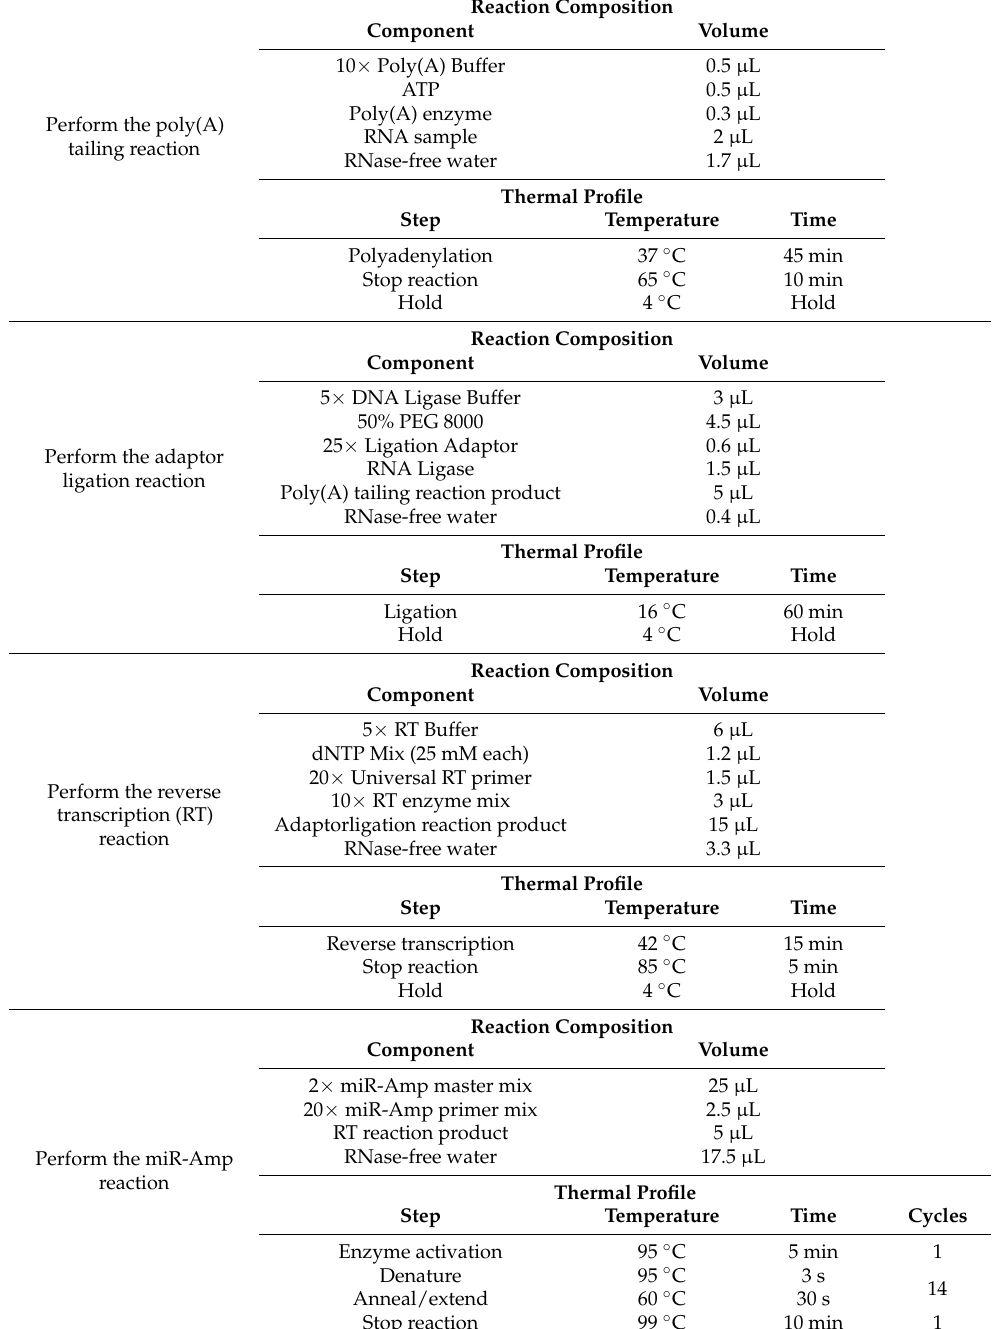
Table 2. cDNA synthesis procedure using TaqMan ® Advanced miRNA cDNA synthesis kit (Applied Biosystems, Foster City, CA, USA) according to manufacturer’s